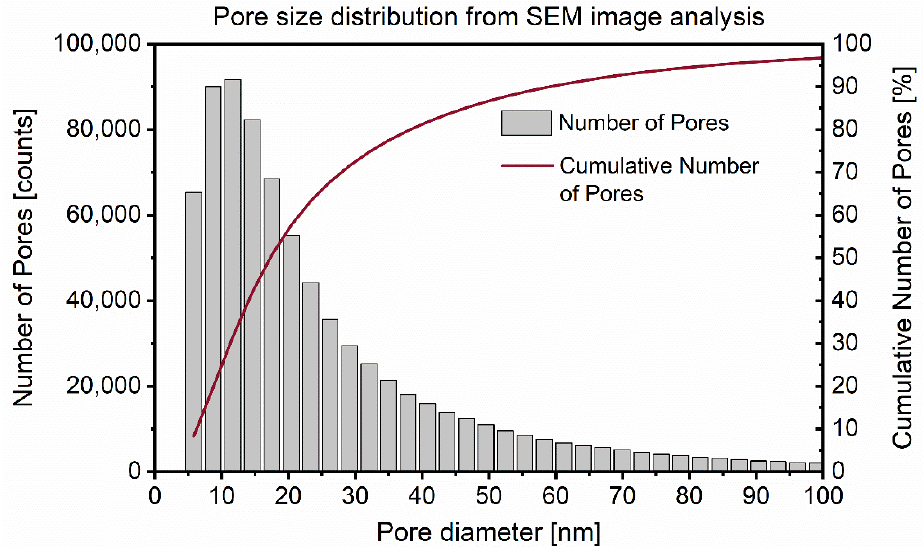
Figure 4. Interhydrate pore size distribution from automated image analysis of Ar-BIB milled 28 d hydrated C 3 S samples. The chord-length density function (CDF) was determined as pore diameter.